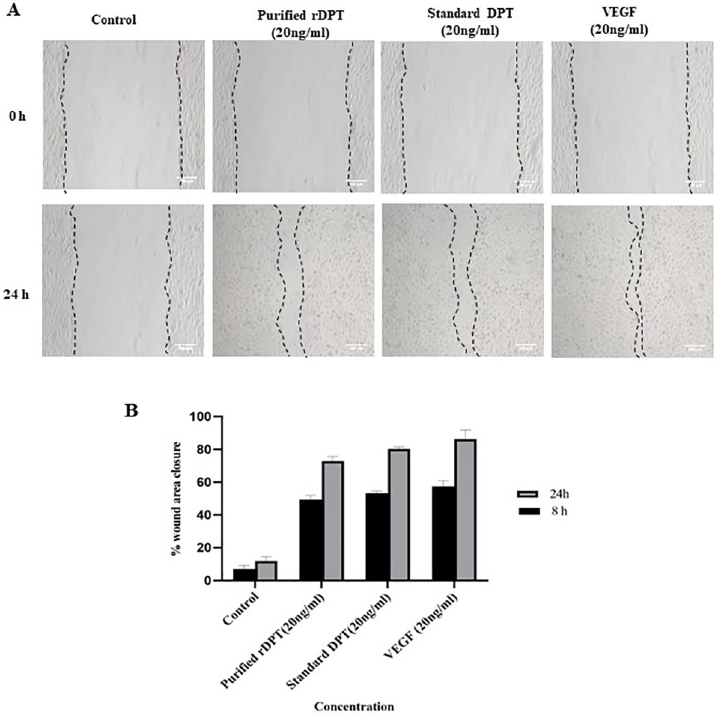
Fig 5. Effect of Dermatopontin (DPT) and Vascular endothelial growth factor (VEGF) on endothelial cell migration. (A) Microscopic images represent the migration pattern of endothelial cells (EA. hy926) treated with equal concentration (20 ng/ml) of purified rDPT, standard DPT and VEGF (positive control) compared to control after a scratch wound was created on confluent endothelial cells cultured on 6-well tissue culture plate. Images of the treated and control wells taken at time 0 h and 24 h post treatment are shown. Scale: 100 μ m. (B) Graphical representation of percentage wound closure after treatment with equal concentrations (20ng/ml) of purified rDPT, standard DPT and VEGF (positive control) compared to control. Values are expressed as mean ± standard deviation. The percentage wound closure in all treatment groups were statistically significant compared to control group (p < 0.05).